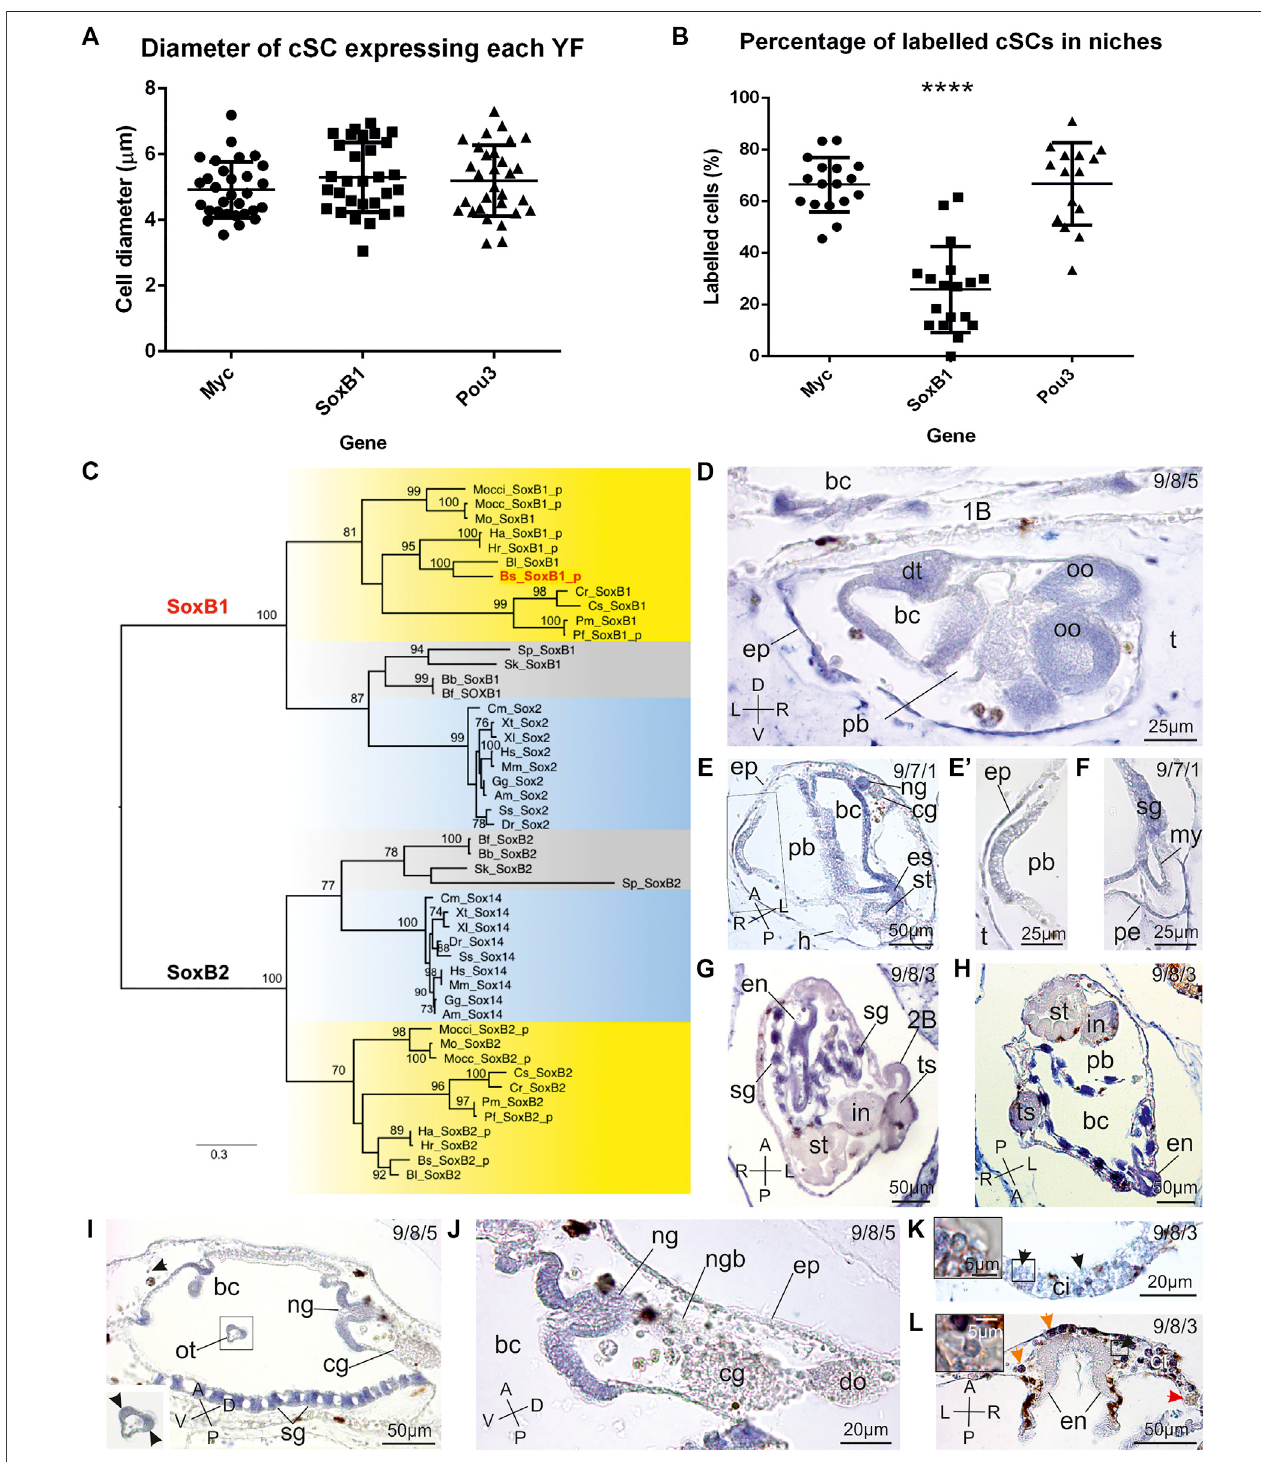
FIGURE3| MorphometricsanalysesoflabelledcandidateSCsinniches, SoxB evolutionand SoxB1 expressionpatternin B.schlosseri . (A) Histogramshowingthe diameter of cSCs found labelled in niches. Statistical tests show no signi fi cant difference among the diameter of cells expressing Myc , SoxB1 and Pou3 . (B) Histogram showing the percentage of cSCs found labelled in niches. Candidate SCs found positive for the expression of SoxB1 are signi fi cantly less numerous than cSCs expressing Myc and Pou3 (****= p -value < 0.0001,ANOVAtest),butthehighpercentageofcellsexpressingtheselasttwogenessuggestacoexpressioninatleast apart ofcSCs. (C) MLevolutionarytreeofthe SoxB subgroup(524aminoacidsites; best- fi tsubstitution modelJTT+G+I+F;bootstrapon100replicates; SoxB2 cluster